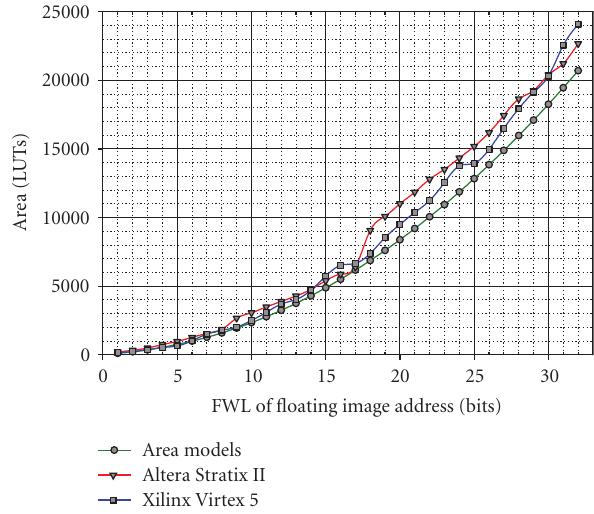
Figure 4: Comparison of the area values predicted by the adopted area models with those obtained after physical